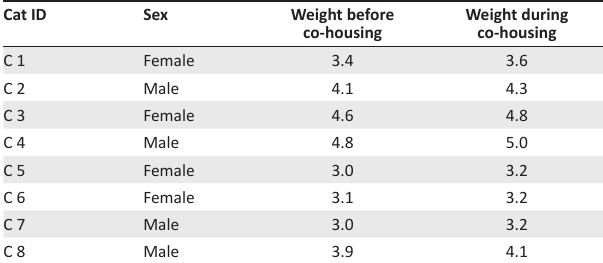
TABLE 3: Domestic cats’ weight (kg) before and during housing next to vervet monkeys. Cat ID